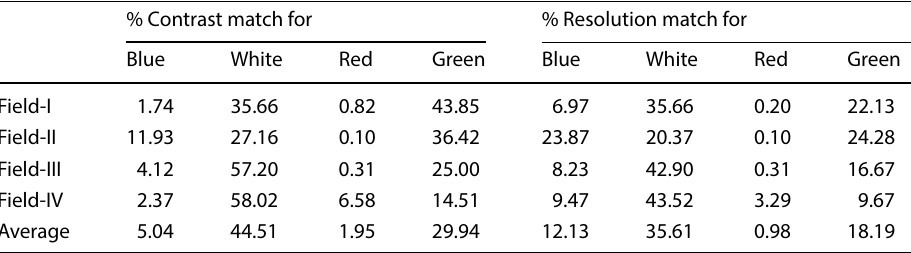
For Q3 overall view while considering both ease of identification and sharpness of borders % Contrast match